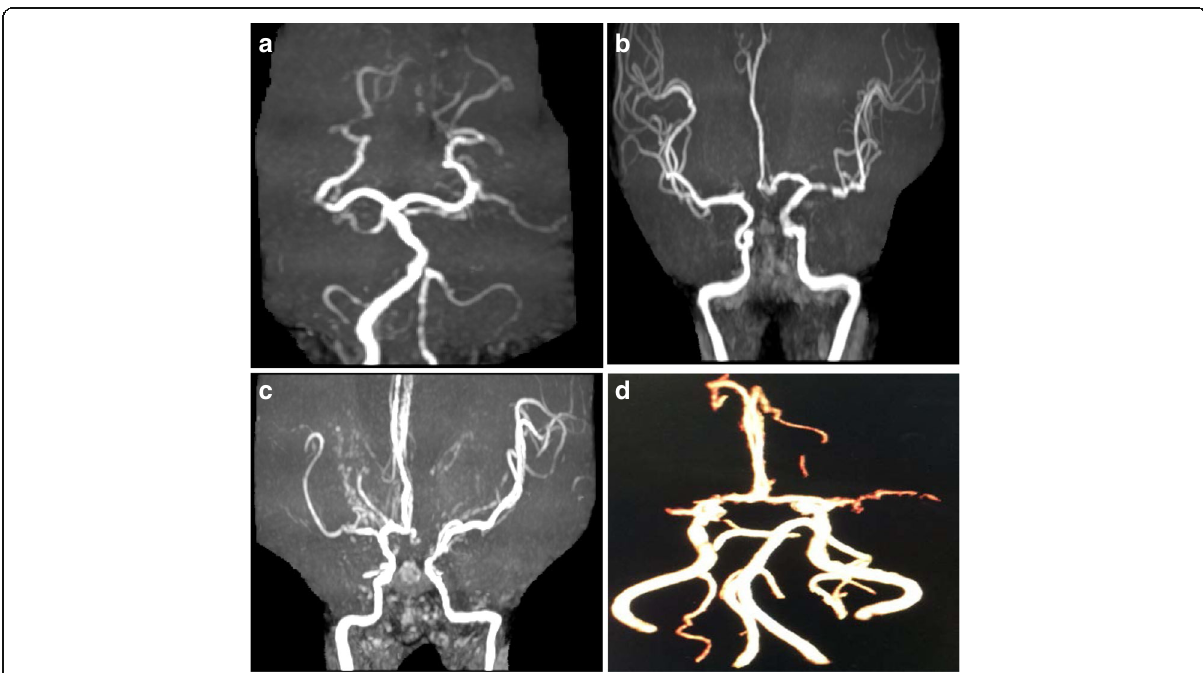
Fig. 1 Magnetic resonance angiography (MRA) images of 4 patients with the p.R4810K variant in ICASO patients. a Case 1 was a 80- year- old woman with occlusion of bilateral anterior inferior cerebellar artery and stenosis of left vertebral artery. The patient was relatively elderly and had hypertention, diabetes, hyperlipidemia and coronary heart disease for many years. b Case 2 was a 52- year- old woman with occlusion of the A1 segment of right anterior cerebral artery and stenosis of the left middle cerebral artery. She had serious hypertension (190/100 mmHg) for 1 month. c Case 3 was a 42- year- old man with occlusion of the A1 segment of left anterior cerebral artery. The patient had hypertension and diabetes both for 5 years. d Case 4 was a 48- year- old woman with bilateral middle cerebral artery and the right anterior cerebral artery stenosis. She also had hypertension and diabetes for several